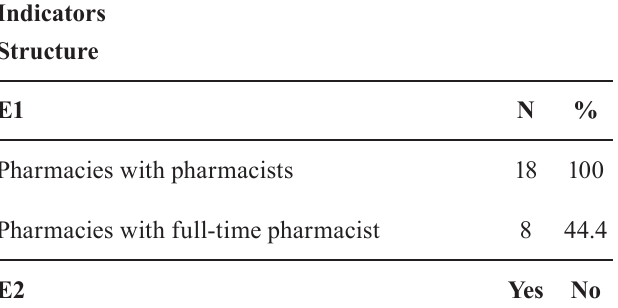
TABLE I - S tructure indicators (E1, E2 and E3) of PS in PHC, in 2015 and 2016.